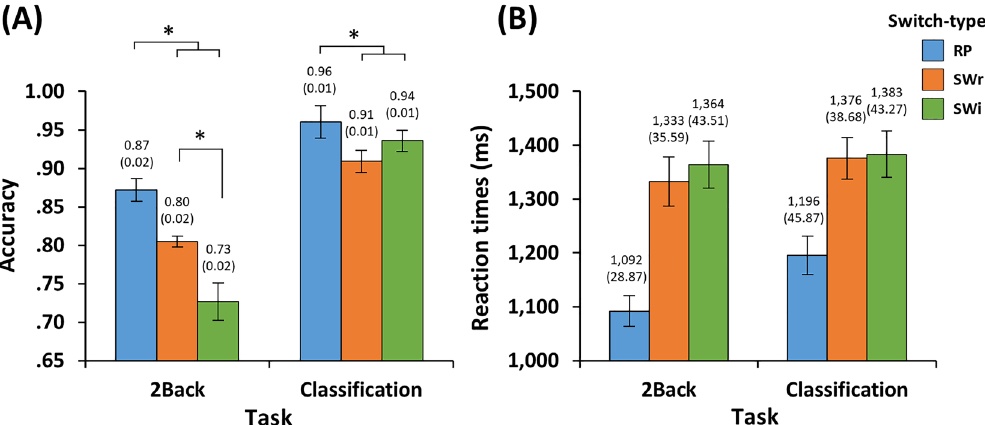
Figure 2. Behavioral results. Mean ( A ) accuracy and ( B ) reaction times for each experimental condition. The post-hoc pairwise comparisons were tested using paired simples t-tests based on significant interactions. Error bars indicate the standard error of the means. RP repeat, SWr switch-relevant, SWi